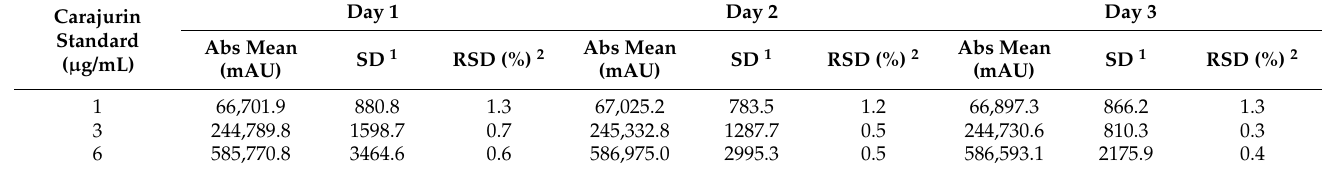
Table 4. Results of inter-day precision analysis of the new analytical method for quantification of